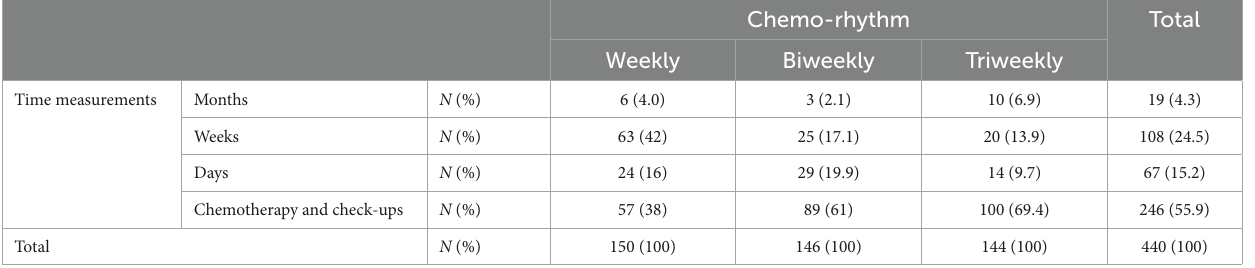
TABLE 2 Chemo-rhythm and time measurements.